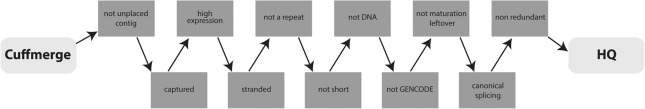
Filtering pipeline flowchart. The input is the comprehensive annotation returned by Cuffmerge. Then, we apply the series of 11 filters described in the text. The output is the high quality set (HQ).